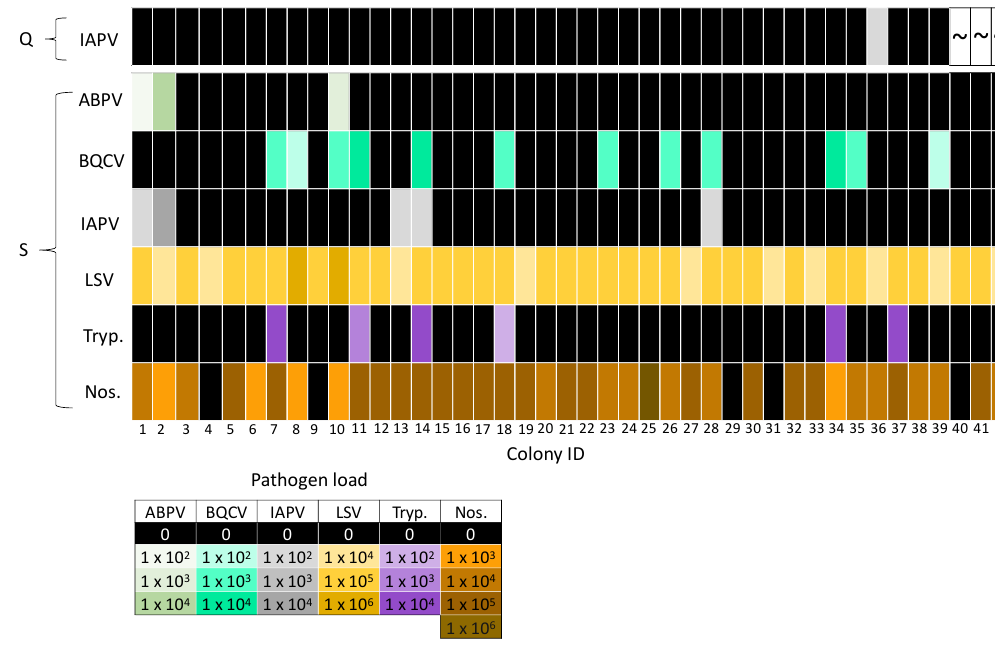
Figure 5. Heat map of pathogens detected in queens (Q) and pooled worker samples from source colonies (S). Queens were negative for ABPV, BQCV, LSV, Trypanosome (Tryp.), and Nosema (Nos.), so these data were not displayed. Colony IDs are displayed on the x axis. Pathogen loads are indicated by color intensity, whereby darker shades indicate higher loads, black represents negative samples, and “~” represents the three queens that died.